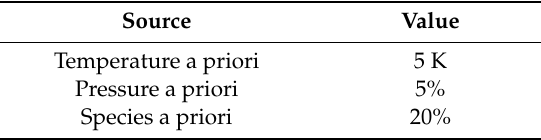
Table 5. Uncertainties assumed for external